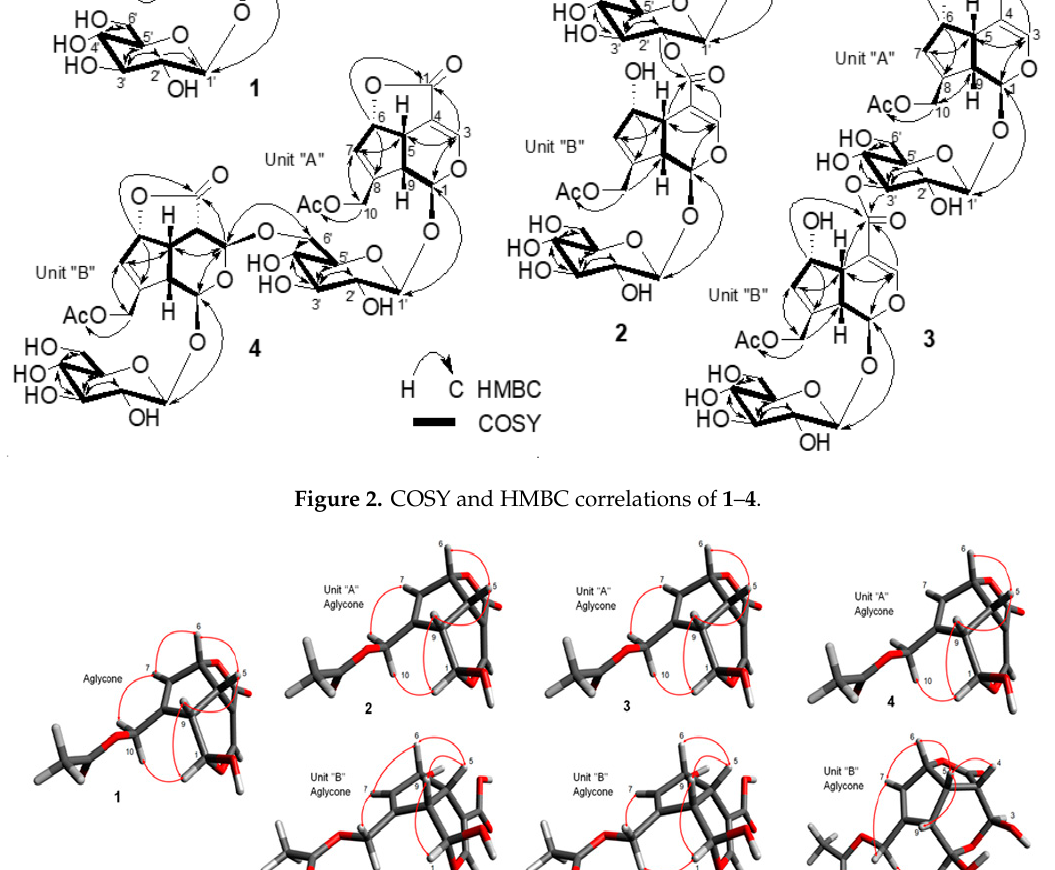
Figure 3. Key NOE correlations of 1 – 4 .